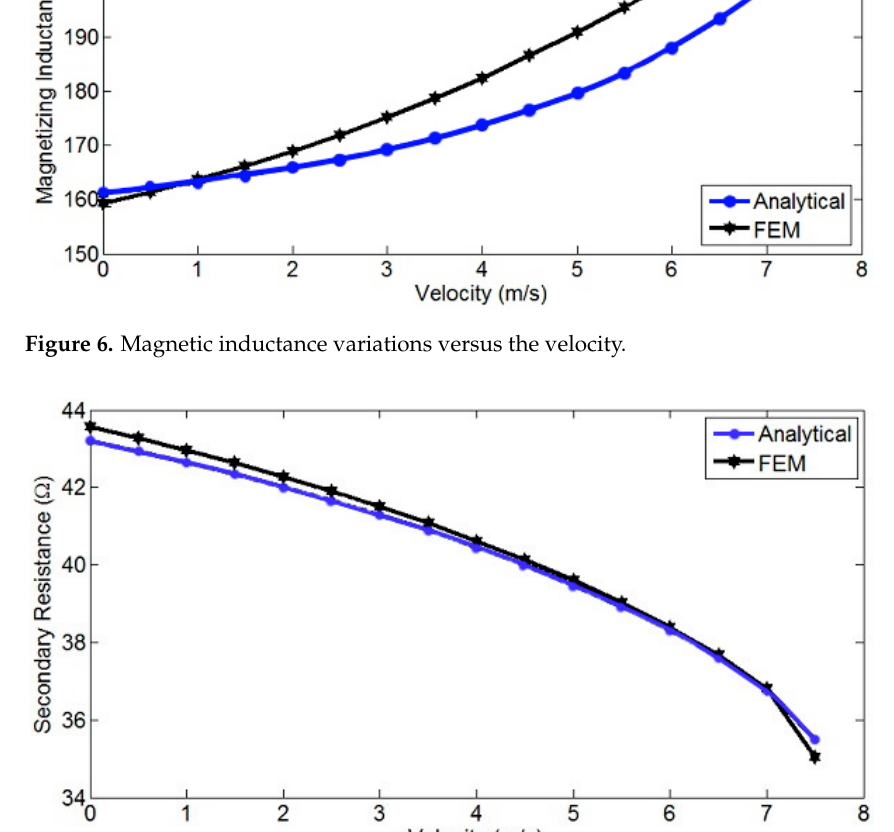
Figure 7. Secondary equivalent resistance variations versus the velocity. Table 2. Equivalent circuit parameters of the